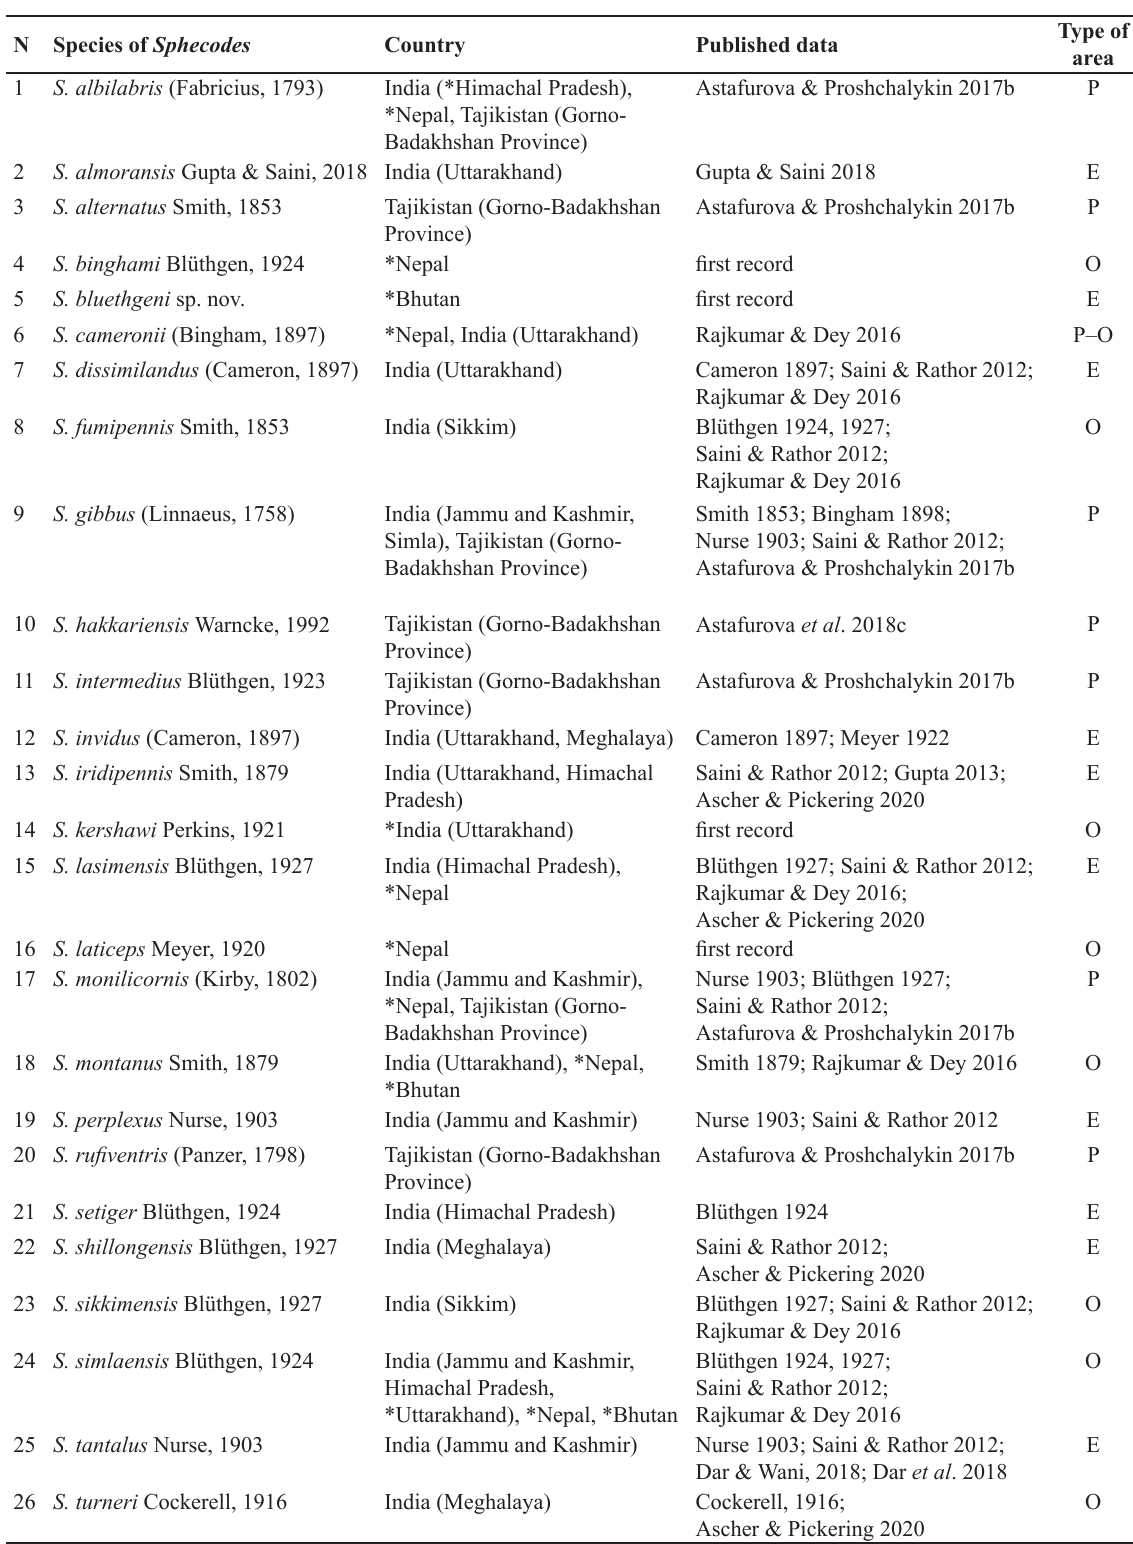
Table 1. Checklist of the species of Sphecodes Latreille, 1804 of the Himalayas including distribution by countries and provinces. Abbreviations: P = Palaearctic species; O = Oriental species; E = endemic. N Species of